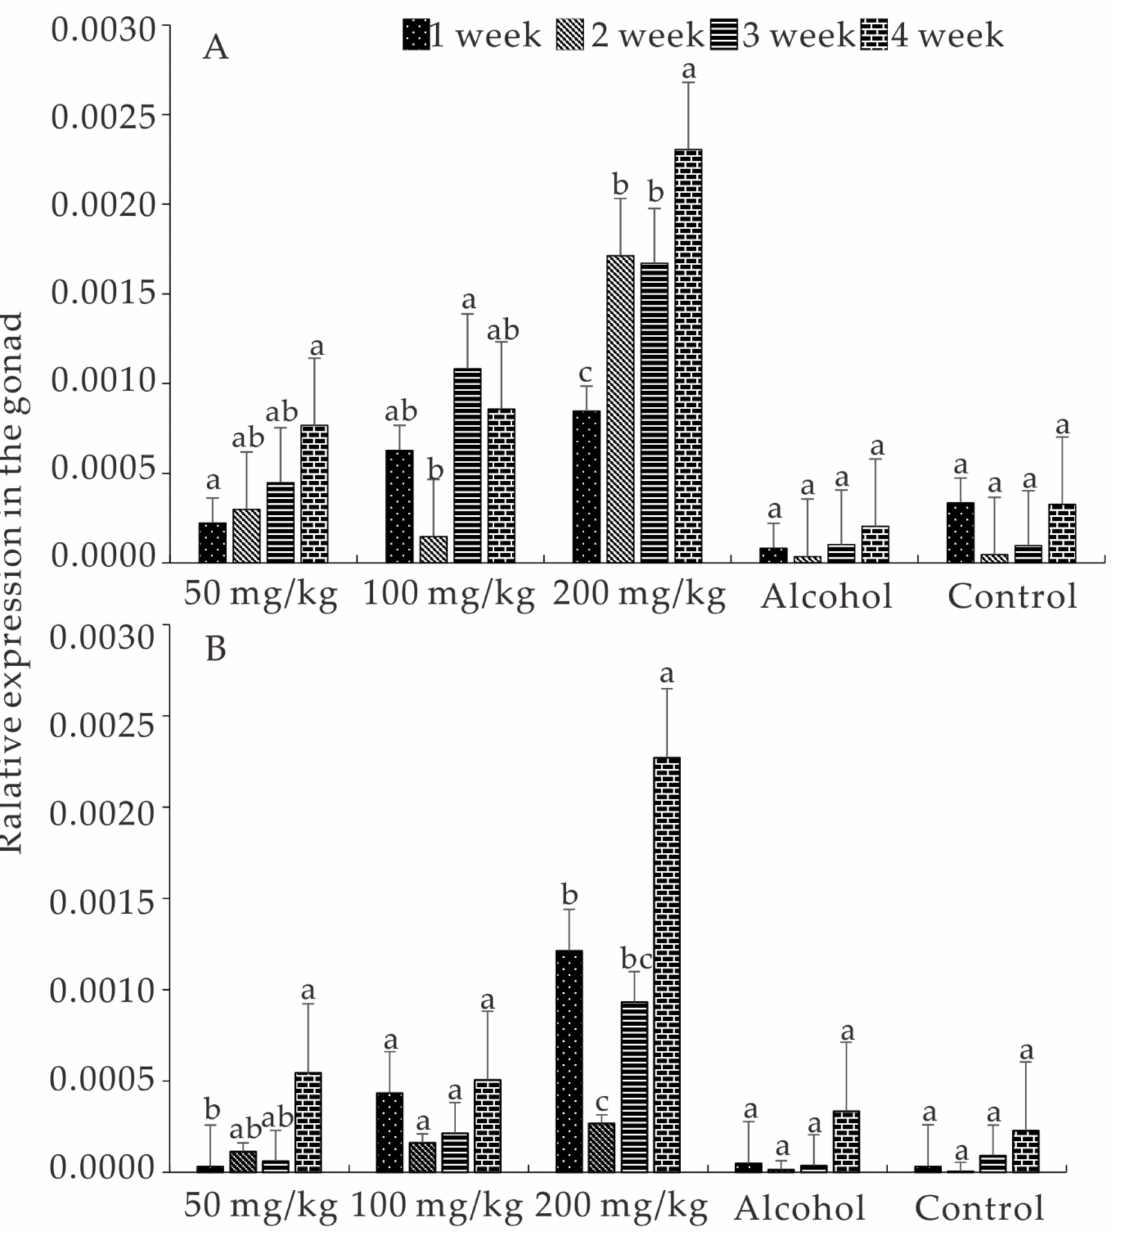
Figure 5. Concentration and time effects of ALK5 ( A ) and BMPR2 ( B ) expression in E 2 -fed S. prenanti . The data are represented as the means ± SEMs (n = 10). Means marked with different letters are significantly different ( p <